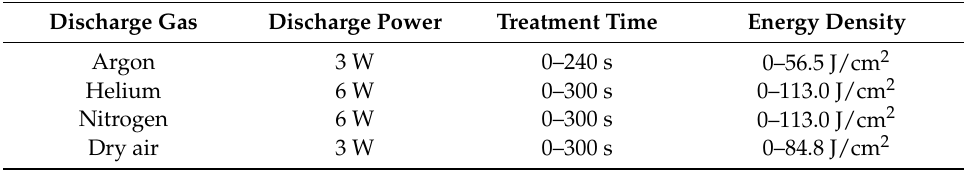
Table 1. Plasma treatment parameters for the different discharge